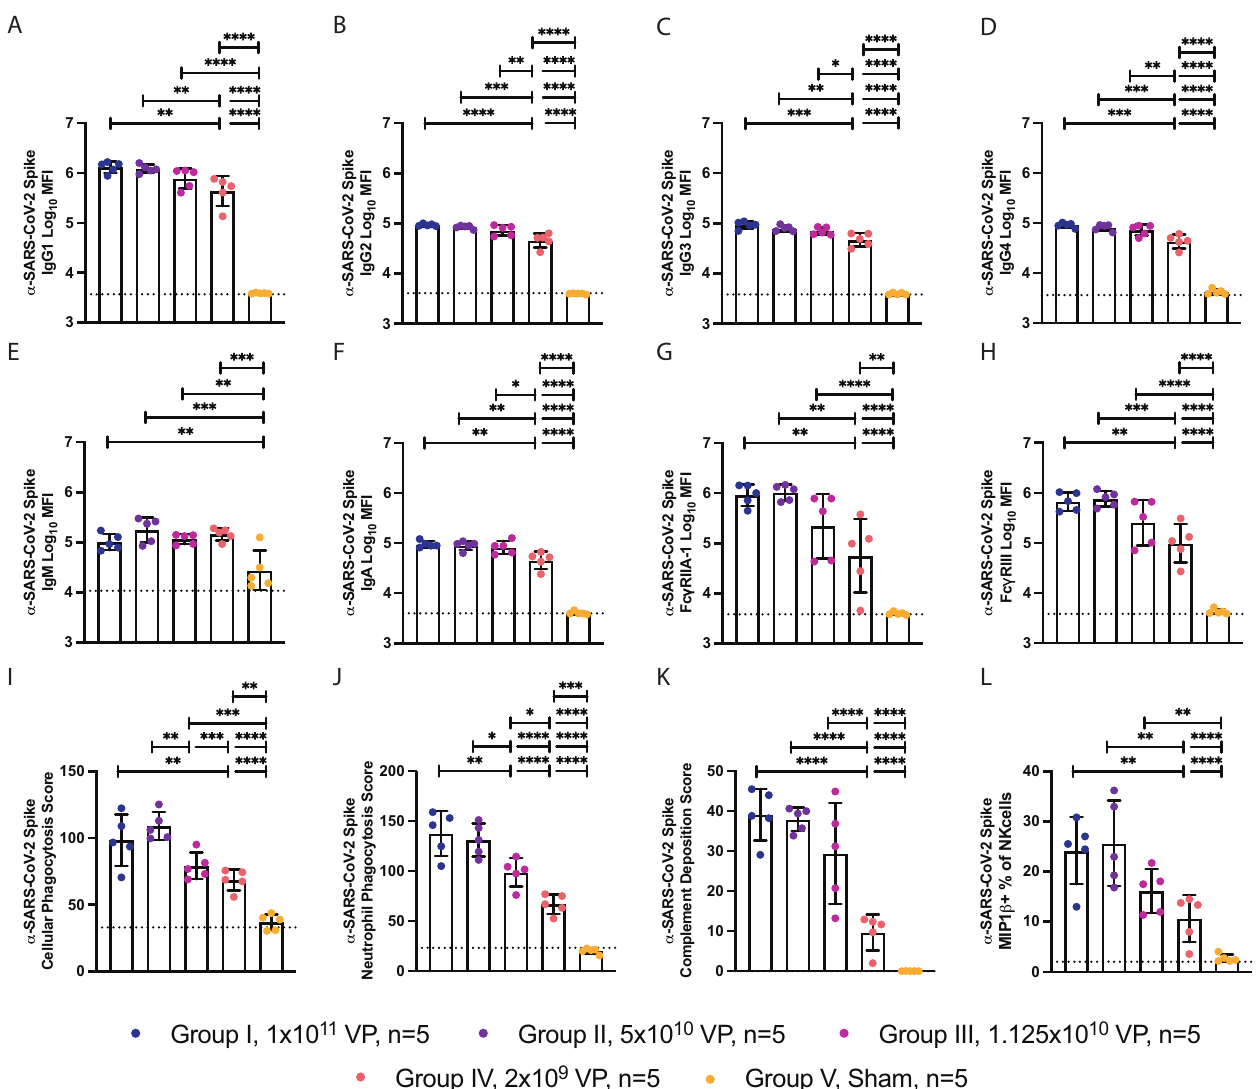
Fig 2. System serology profiling of anti-Spike antibodies from Ad26.COV2.S vaccinated NHPs. (A) The humoral response against SARS-CoV-2 Spike was profiled using system serology. (B–G) The titer of IgG1 (B), IgG2 (C), IgG3 (D), IgG4 (E), IgM (F), and IgA (G) antibodies against SARS-CoV-2 were profiled using Luminex. (H, I) The titer of anti–SARS-COV-2 antibody binding to Fc γ RIIA-1 (H) and Fc γ RIII (I) were profiled using Luminex. (J–M) The graphs represent the ability of the humoral response to stimulate ADCP (J), neutrophil phagocytosis (ADNP) (K), complement deposition (ADCD) (L), or NK cell activation (NKdegran) (M) when stimulated with antigen-coated beads or plates. Bars represent the mean, and error bars represent the standard of deviation. This figure can be generated from the data found in data/figure2_data.csv of https://github.com/dzhu8/Ad26-Dose-Down. ADCD, antibody-dependent complement deposition; ADCP, antibody-dependent cellular phagocytosis; ADNP, antibody-dependent neutrophil phagocytosis; MFI, median fluorescent intensity; NHP, nonhuman primate; NK, natural killer; SARS-CoV-2, Severe Acute Respiratory Syndrome Coronavirus 2; VP, viral particle.